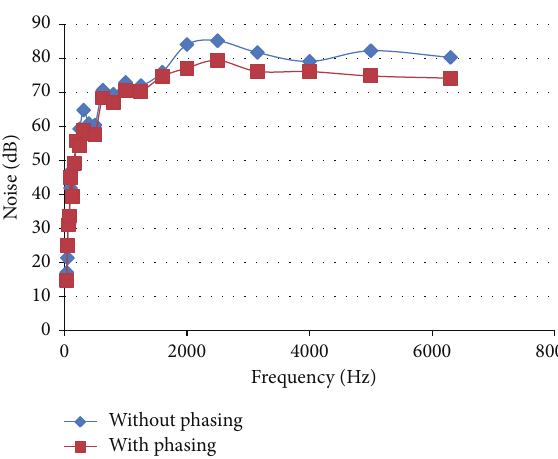
Figure9:Comparisonofload(kg)withnoise(dB)withoutandwith phasing.